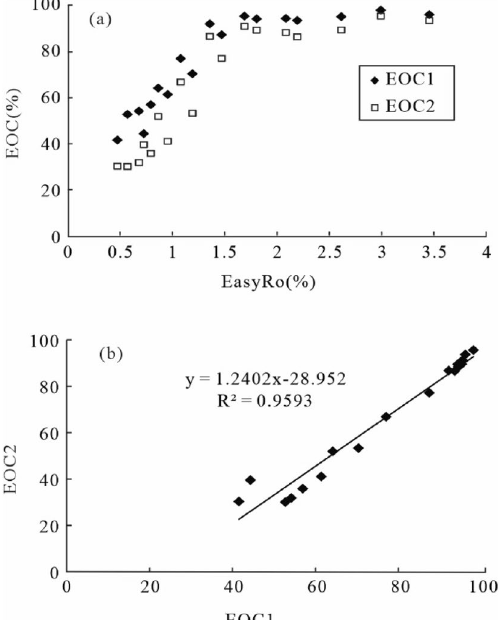
Figure 8. Relationships between: ( a ) EOC (%) and EasyRo (%), ( b ) the actual EOC2 (%) and the calculated EOC1 (%). EOC1: the calculated EOC (%) from (1 − C 0 /C c ) × 100; EOC2: the actual EOC (%).